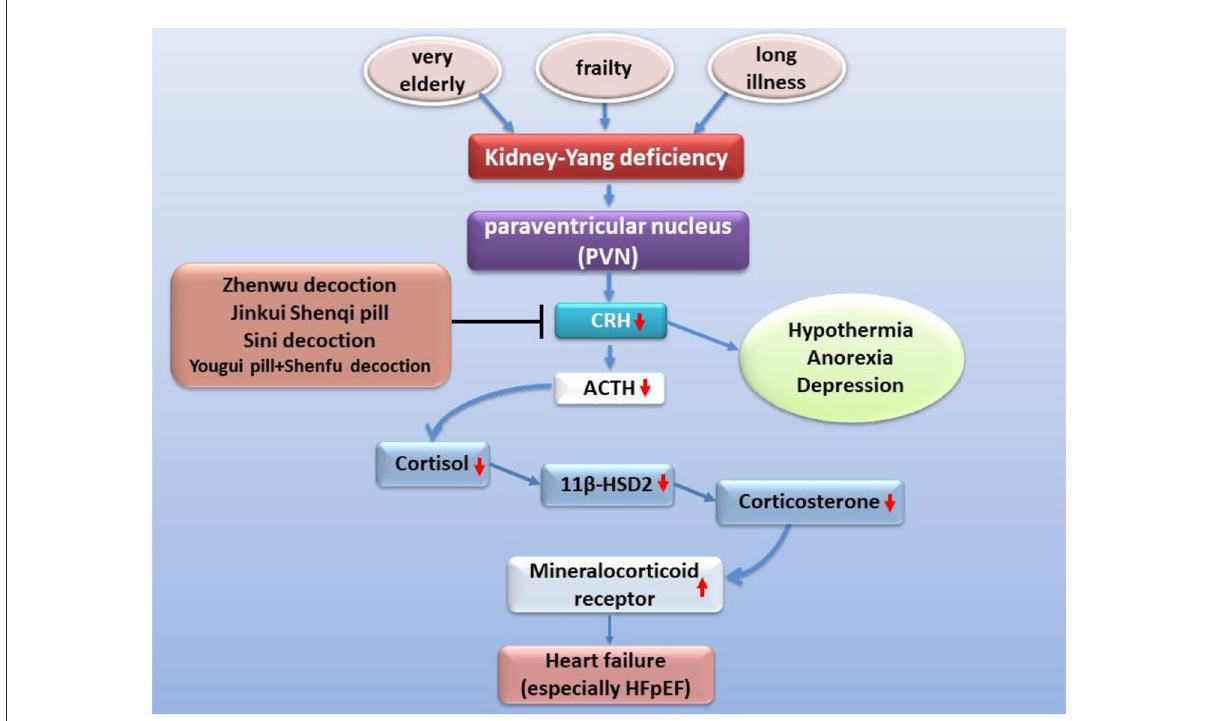
FIGURE3 Improvement of heart failure by classic prescription via HPA axis. Kidney Yang deficiency is linked to heart failure via the hypothalamic-pituitary-adrenal axis. Under the condition of kidney-Yang deficiency driven by factors such as advanced age, the secretion of CRH secreted by PVN decreases, the activation of the hypothalamic-pituitary-adrenal axis is inhibited, the expression of 11 β -HSD2 drops while the expression of mineralocorticoid receptor (MR) rises, cardiac hypertrophy and fibrosis, and functional events